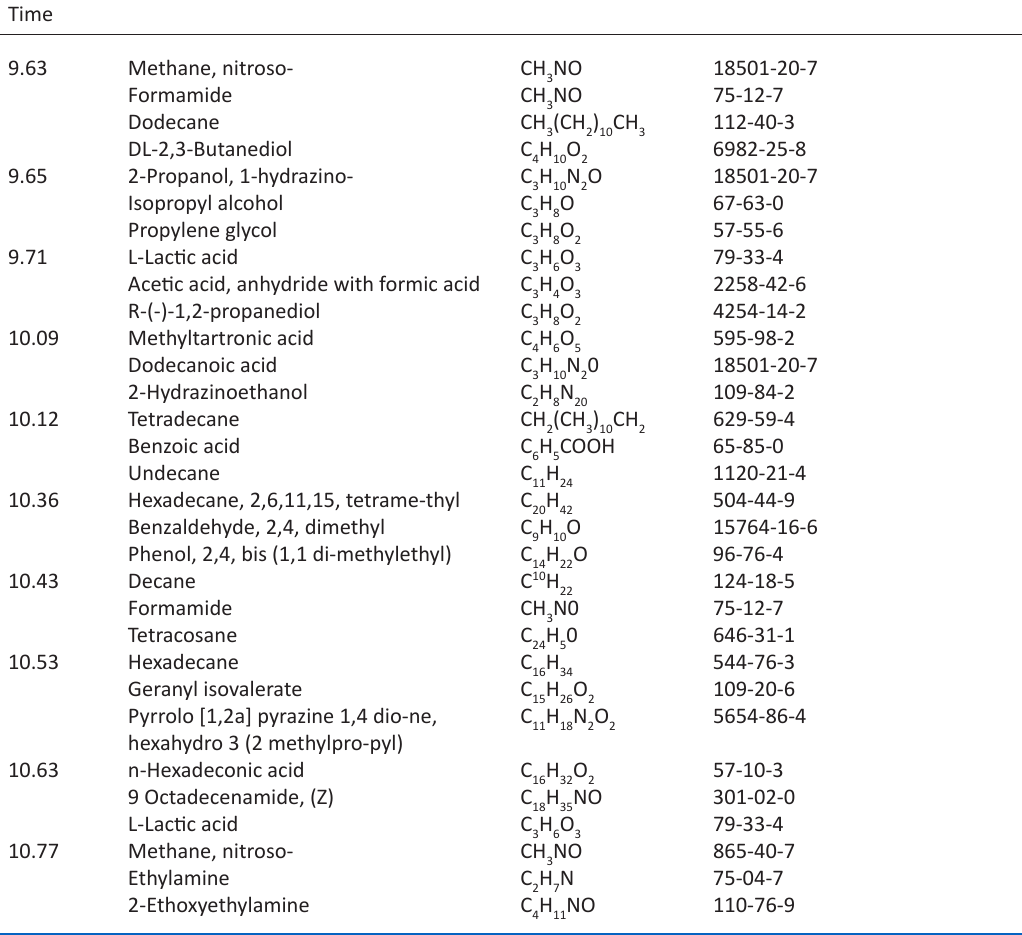
Table 3. Metabolic profile of biocomponents identified in solvent extract of probiotic Lactic acid bacteria isolates by GC-MS a) Lactobacillus plantarum DB-2 Retention